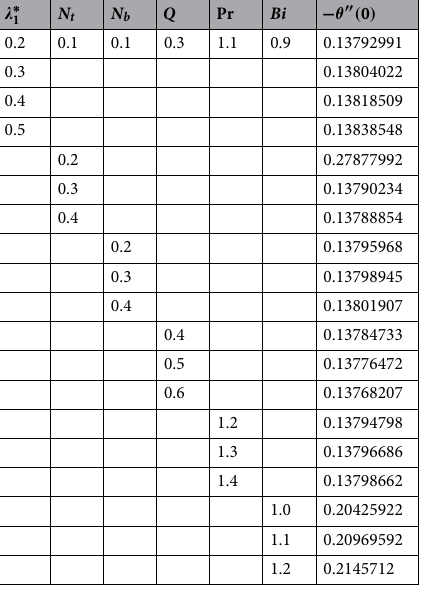
1 /2 ex for different parameters.